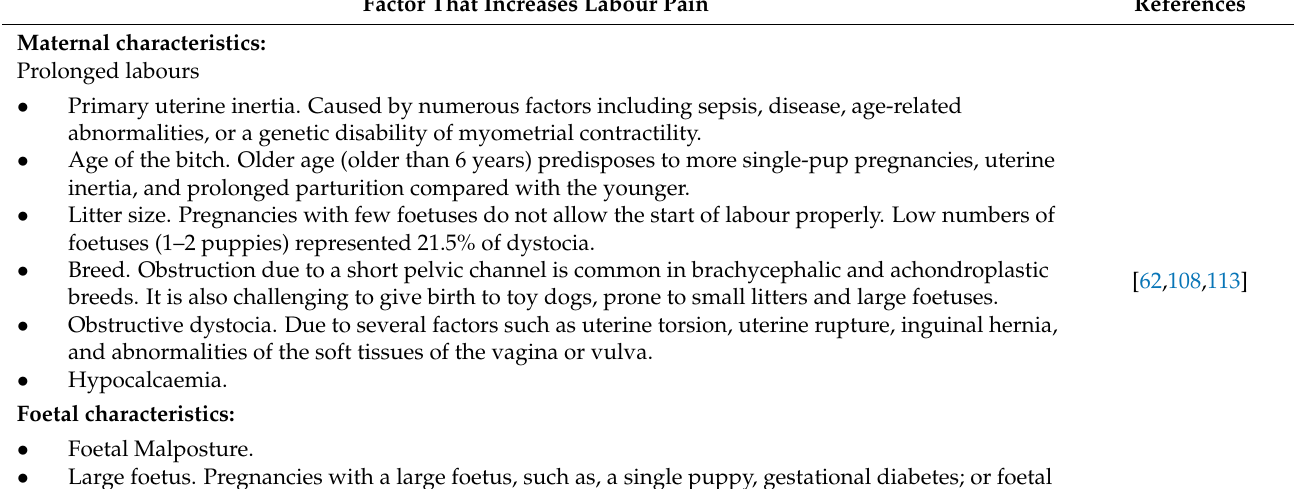
Table 2. Factors associated with dystocia, prolonged farrowing and pain in the bitch. Factor That Increases Labour